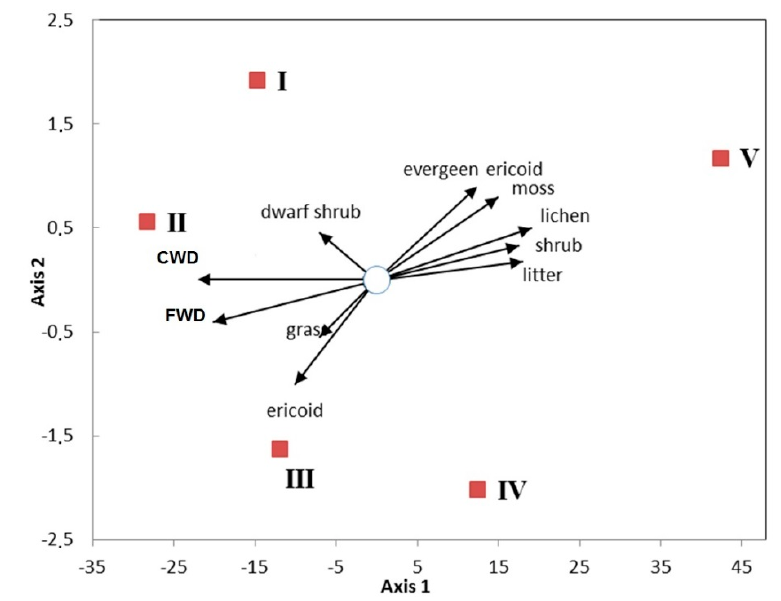
Figure 7. Relationship of the richness of morphological groups of fungi with biomass and mortmass of vegetation. Axis 1—biomass of the tree layer, Axis 2—morphological groups of fungi. I–V represent the altitudinal levels.